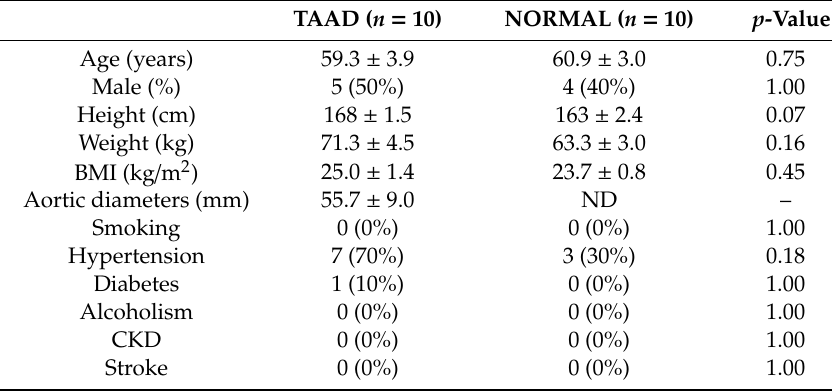
Table 1. Clinical information of TAADs and normal samples.